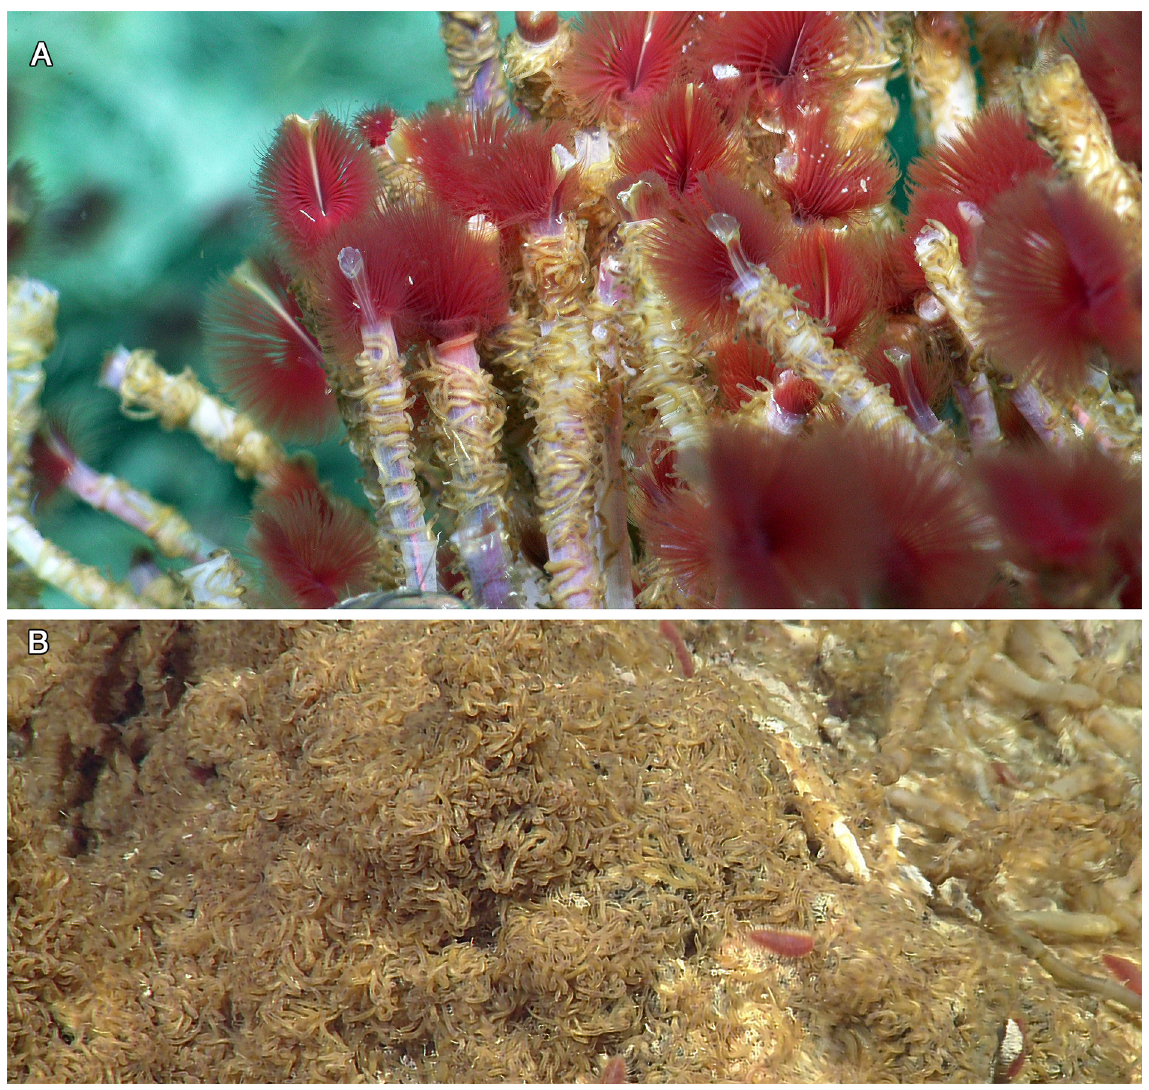
Fig. 6. Ophryotrocha marinae sp. nov. A . Numerous specimens associated with the tubes of Oasisia alvinae Jones, 1985 (Vestimentifera) at active hydrothermal vents of the Pescadero Basin (Mexico). Image from ROV SuBastian dive S0495, courtesy of the Schmidt Ocean Institute. B . Numerous specimens associated with microbial mat on the seafloor at active hydrothermal vents adjacent to a large mass of Oasisia alvinae . Some of these were collected and formed lots (SIO-BIC A6308, A1408– 14112). Image from ROV Doc Ricketts dive 750 in the Pescadero Basin, courtesy of the Monterey Bay and Aquarium Research